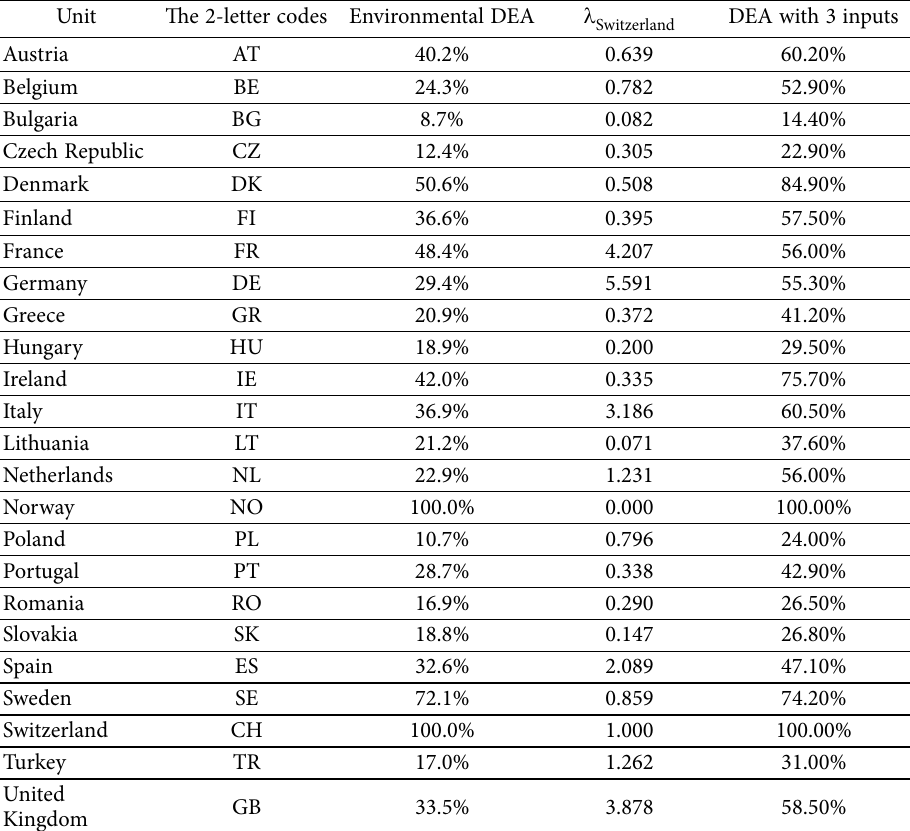
Table 4. Productivity of European countries estimated by DEA